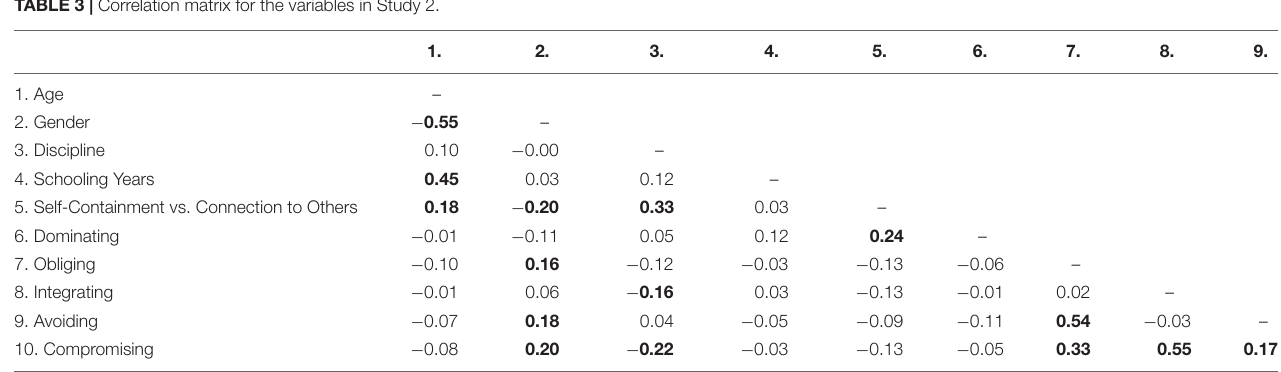
TABLE 3 | Correlation matrix for the variables in Study